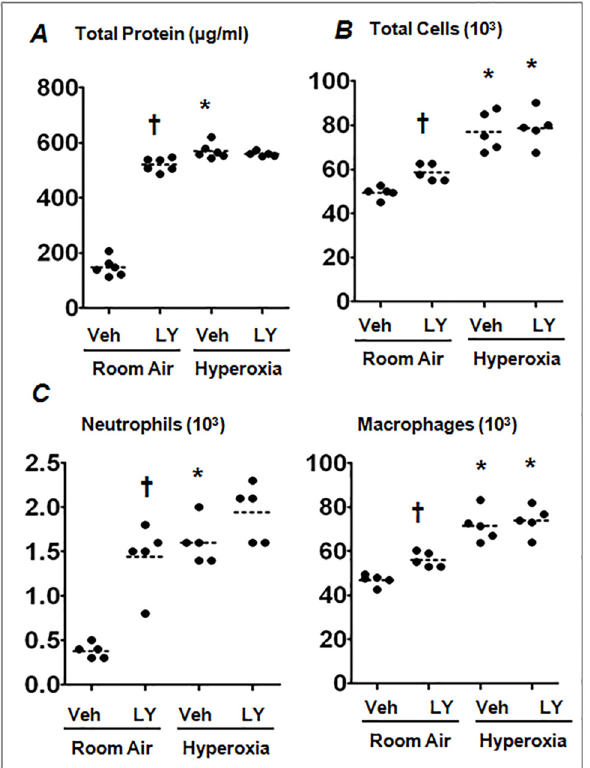
Fig 5. The effects of PI3K/AKT inhibition on hyperoxic lung injury and inflammation in Nrf2 – / – mice. Nrf2 – / – mice were treated with either vehicle or LY and subsequently exposed to hyperoxia or room air as described in Fig 1. (A) Total protein in the BAL fluid of room air or hyperoxia exposed Nrf2 – / – mice treated with vehicle or LY. (B) Total cells in the BAL fluid of room air or hyperoxia exposed Nrf2 – / – mice treated with vehicle or LY. (C) Total neutrophils and macrophages in vehicle or LY-treated mice exposed to room air or hyperoxia. The horizontal and vertical lines were plotted as median ± interquartile range for each group (n = 4 – 5). One- way ANOVA with Bonferroni corrections was performed for multiple group comparisons. * P = 0.05, hyperoxia vs room air; † P = 0.05, vehicle vs LY treated group.